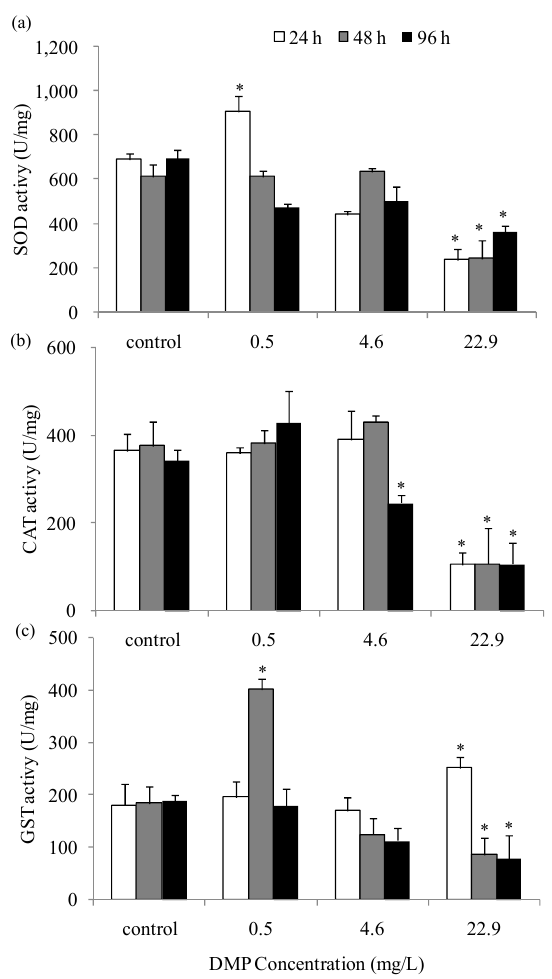
Figure 4. DMP-induced changes of antioxidant enzyme activity in zebrafish liver: ( a ) superoxide dismutase (SOD) activity; ( b ) catalse (CAT) activity; ( c ) glutathione s-transferese (GST) activity. Adult fish were exposed to 0.5, 4.6 and 22.9 mg / L DMP for 24, 48, and 96 h. Statistical significance between the experimental and control groups is indicated with an asterisk: p < 0.05. The error bars represent the standard deviation (n = 5).